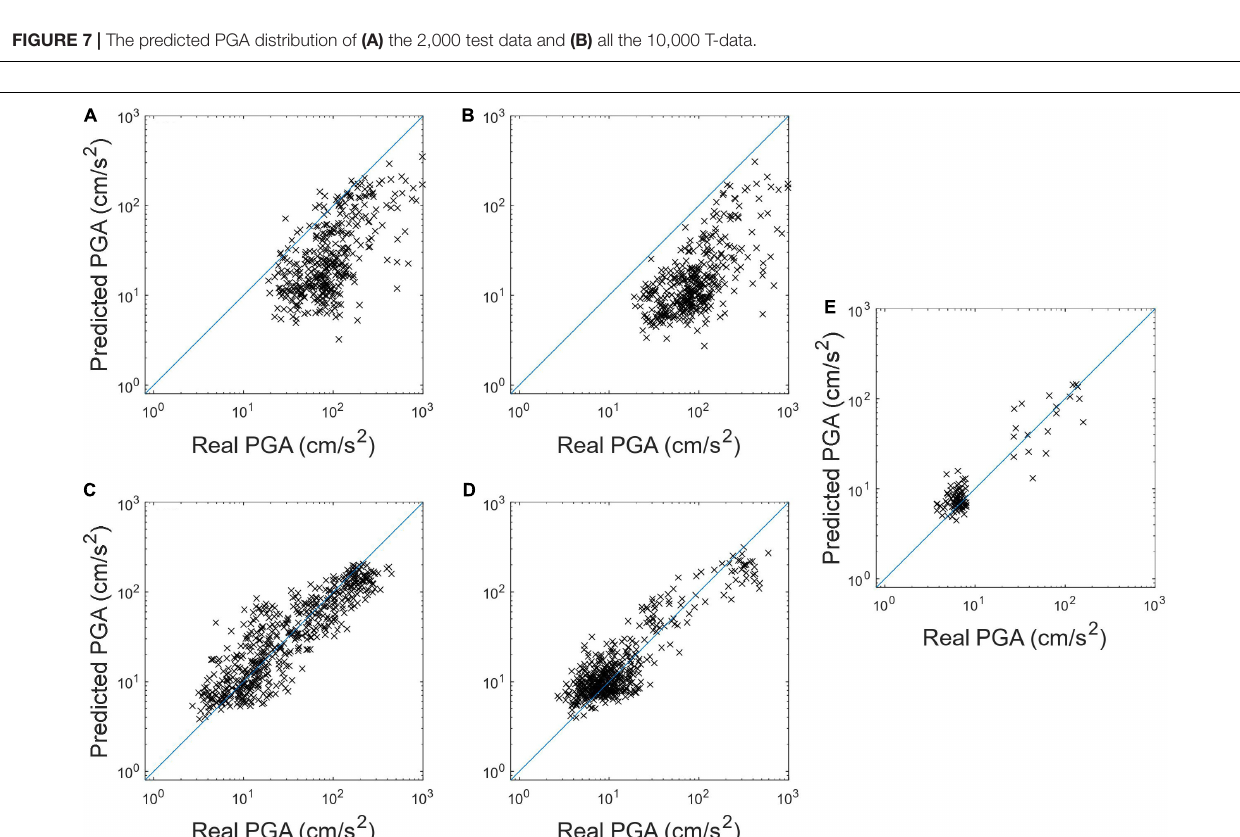
FIGURE 8 | The predicted PGA distribution of the Chi-Chi earthquake event using (A) the proposed CNN approach and (B) the SVR approach in Hsu et al. (2013). The predicted PGA distribution of (C) the Meinong earthquakes, (D) the Hualien earthquakes, and (E) the M5.3 earthquake using the proposed CNN approach.